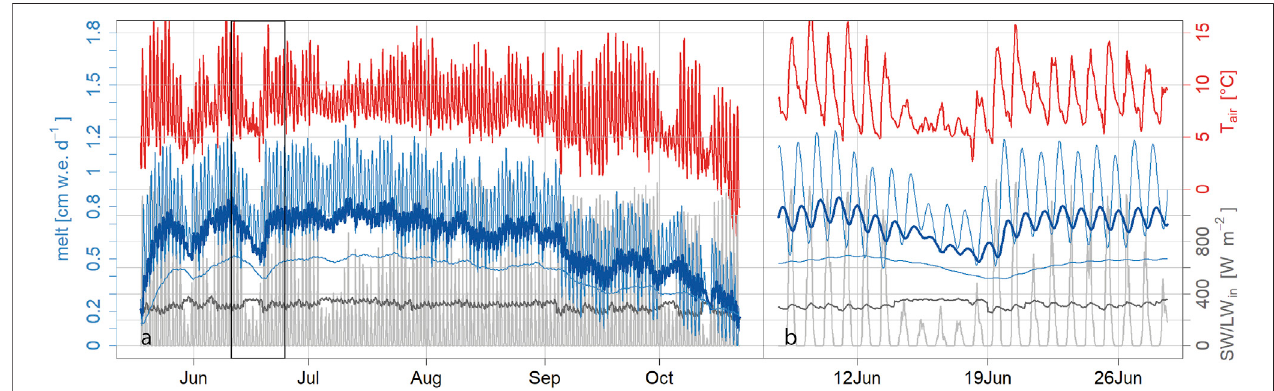
FIGURE 11 |(A) Mean hourly melt ratesduring the model period melt below average debris thickness (50 – 100 cm, thick dark blue line) as well asthick ( > 1 m) and thin ( < 0.5 m, thin lightblue lines belowand above). Additionally shown measured airtemperature(red), incomingshortwaveradiation (light grey) and incoming longwave radiation (dark grey). The black rectangle in panel a shows the boundaries of the inset of panel (B)